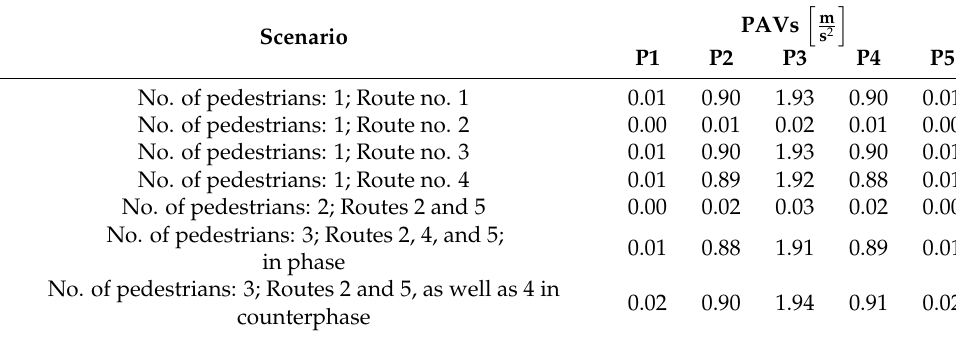
Table 13. The dynamic response of the footbridge for the different configurations of routes for Load Variant 1.2 (f = 1.64